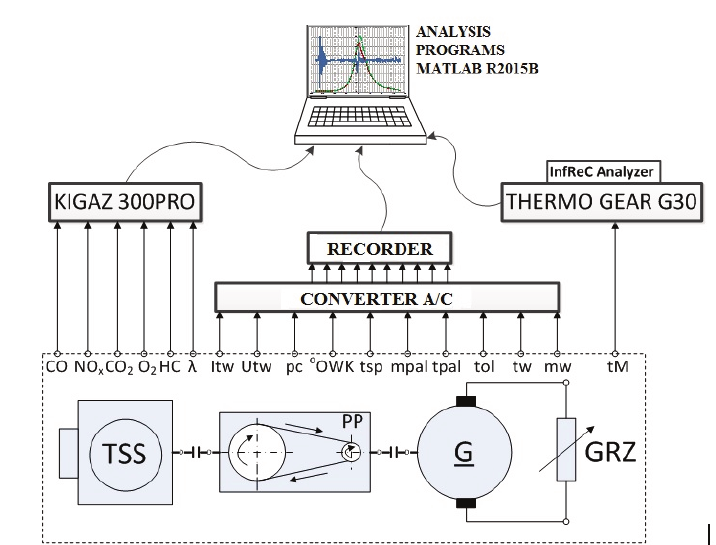
Fig. 1. Schematics of the test stand with the measurement signals recording and processing system: TSS–Farymann D10 diesel engine; PP – belt trans- mission; G – direct current generator; GRZ – system of heaters